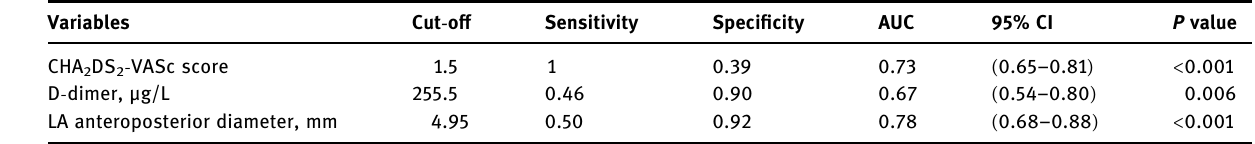
Table 2: ROC curve analysis to predict the cut - o ff values ( CHA 2 DS 2 - VASc scores, D - dimer and LA diameters ) of LAAT